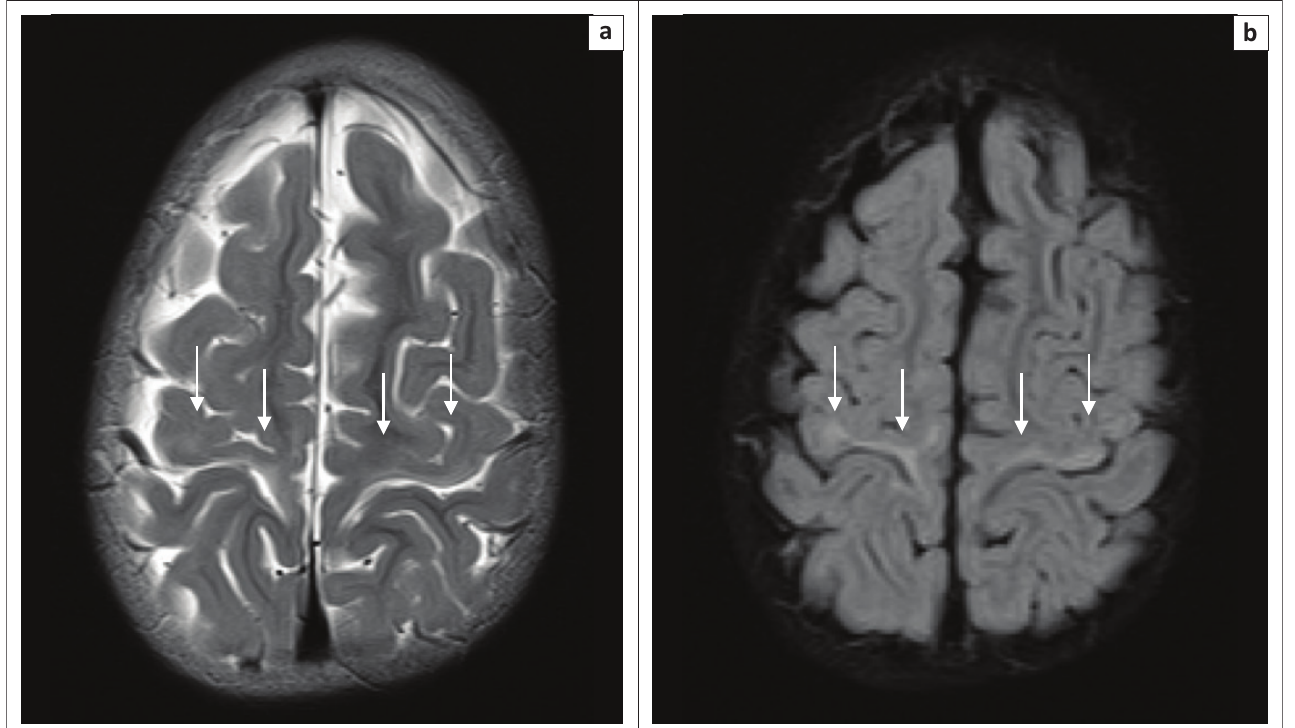
FIGURE 8: Three-year-old male child with history of neonatal encephalopathy, low Apgar scores and seizures. (a) An axial T2-weighted sequence image, which does not demonstrate the perirolandic changes adequately, and these changes would be difficult to diagnose without the axial FLAIR sequence image (b) which shows that the changes are almost exclusively involving the precentral gyrus.